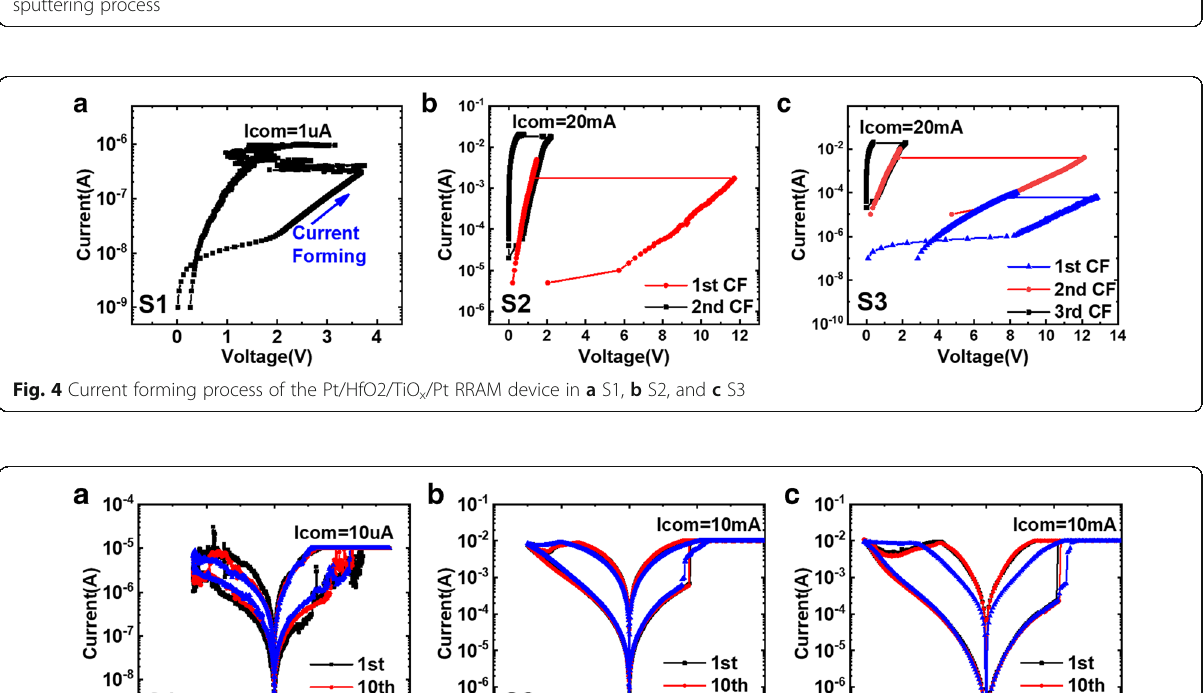
Fig. 3 O 1s XPS scan spectra of TiO x films in S1, S2, and S3. Oxygen partial pressure was set as a 9%, b 11%, and c 13% during TiO x film sputtering